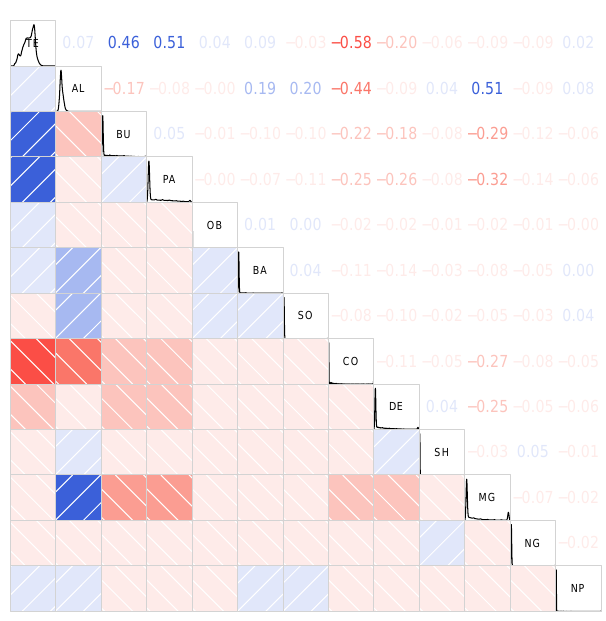
Figure A1. Correlation and density plots for each variable used in our analysis. Blue signifies a positive correlation, while red signifies a negative correlation. Fainter colored boxes and text signify a weaker correlation. TE = surface temperature, AL = albedo, BU=buildings, PA = paved, OB = other built structures, BA = barren ground, SO = soil, CO = coniferous trees, DE = deciduous trees, SH = shrubs, MG = modified grass or herb, NG = natural grass or herb, NP = non-photosynthetic vegetation. Table A1. Summary of model of effects of land cover class and albedo on surface